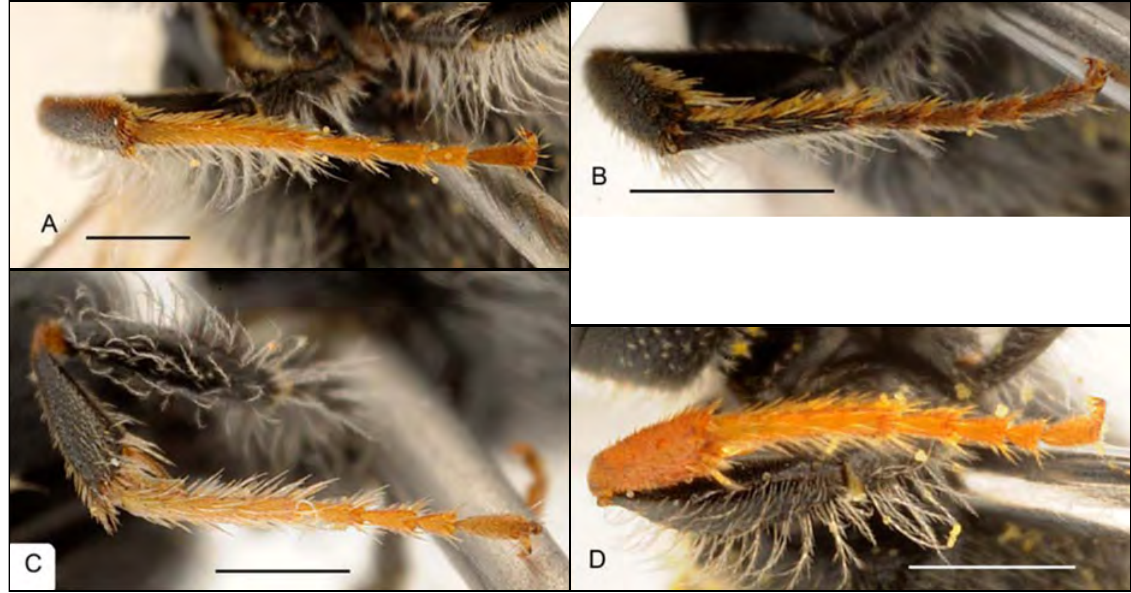
Fig. 13. ♂ foretarsi. — A . Lasioglossum ( Capalictus ) mosselinum (Cockerell, 1945) . — B . Lasio- glossum ( Capalictus ) timmermanni sp. nov. — C . Lasioglossum ( Capalictus ) hantamense sp. nov . — D . Lasioglossum ( Capalictus ) tigrinum sp. nov. Scale line = 0,5